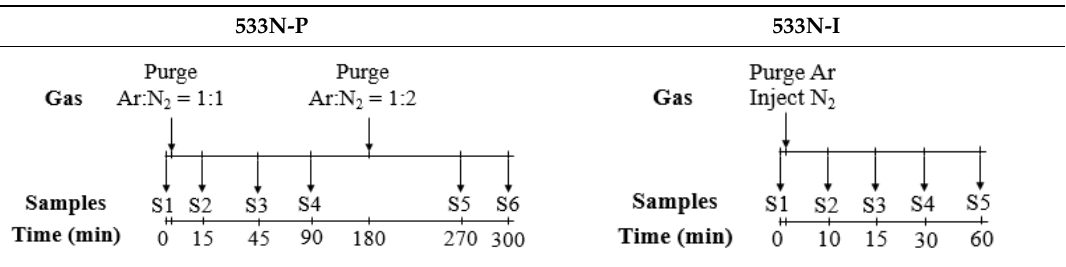
Table 5. Morphologies of AlN (pure) inclusions.